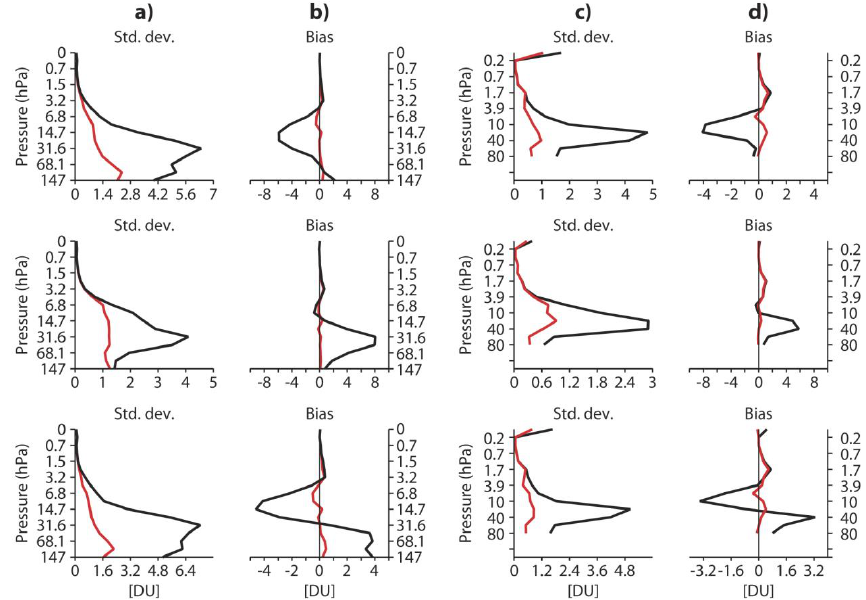
Figure 9. (a) Annual mean SD of MLS analysis departures and (b) MLS analysis departures, as well as (c) SD of MIPAS analysis departures and (d) MIPAS analysis departures in DU from CIFS-AN (red) and CIFS-CTRL (black) averaged over the NH (90–20 ◦ N, top), the tropics (20 ◦ N–20 ◦ S, middle) and the SH (20–90 ◦ S, bottom) for all good data in 2008.